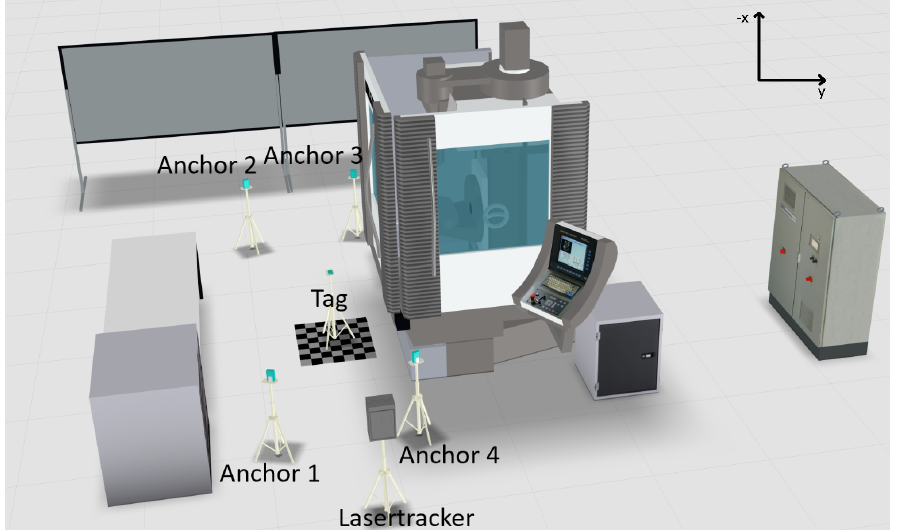
Figure 7. Visualization scenario 3: Four lines of sight.